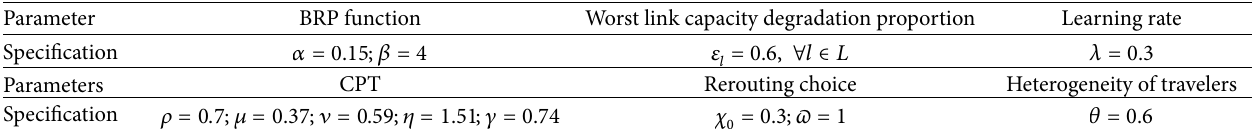
Table 3: Basic numerical settings.